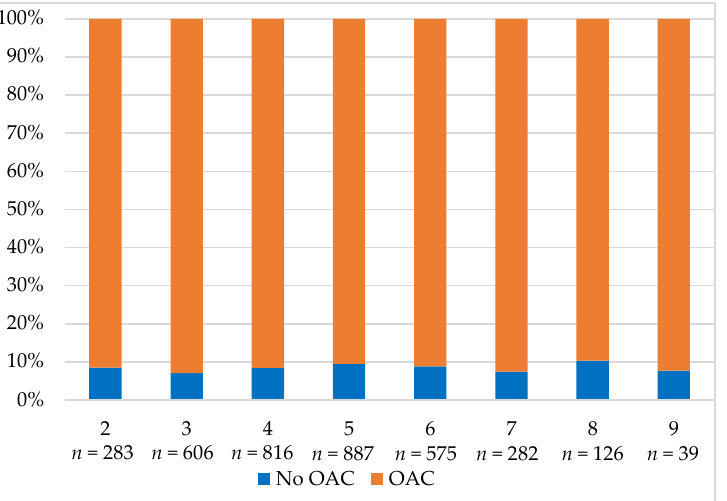
Figure 2. The prescription of OAC based on the CHA 2 DS 2 -VASc score. Abbreviation: OAC, oral anticoagulant.